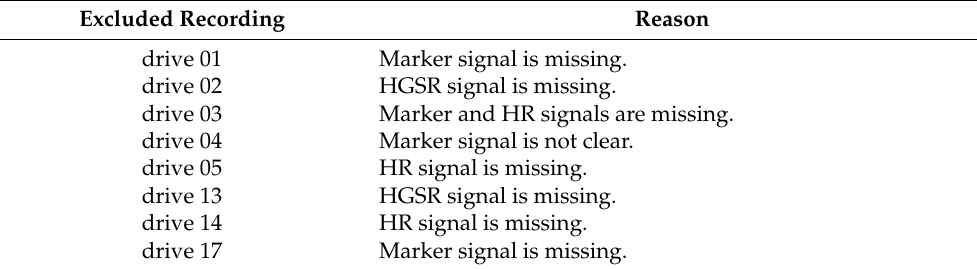
Table 2. Excluded recordings in our paper and the